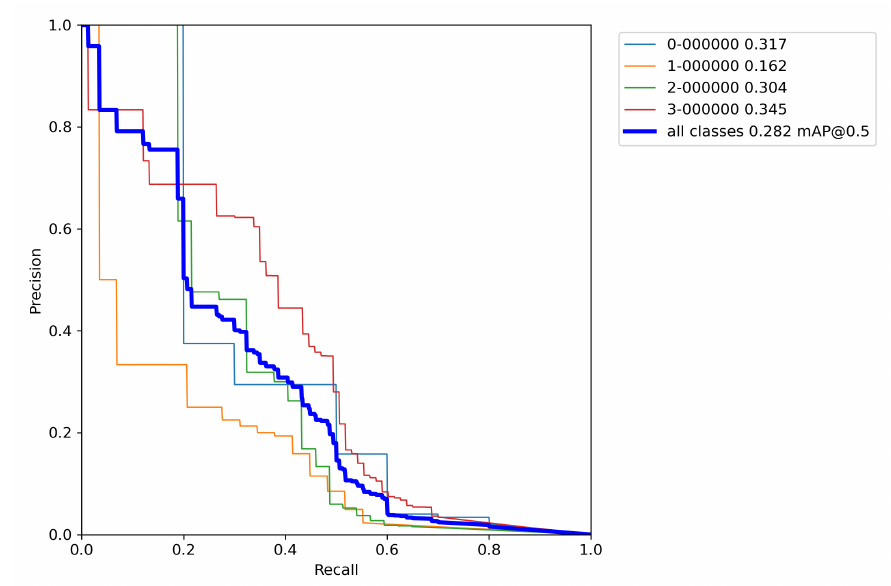
Figure A5. Base model P–R curve—Experiment